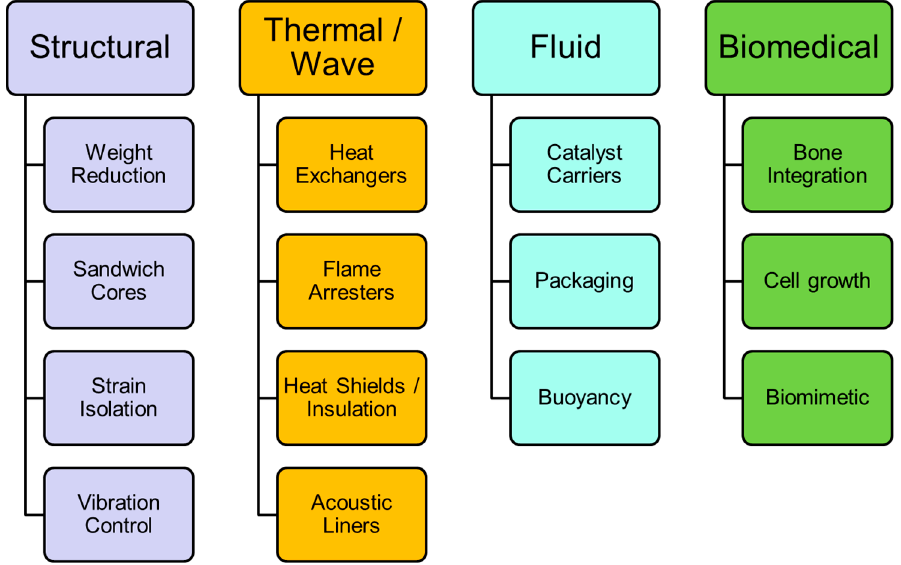
Figure 1. Applications for cellular structures that can leverage their special properties to enhance functional performance (adapted from a design guide on metal foams [3]). functional performance (adapted from a design guide on metal foams